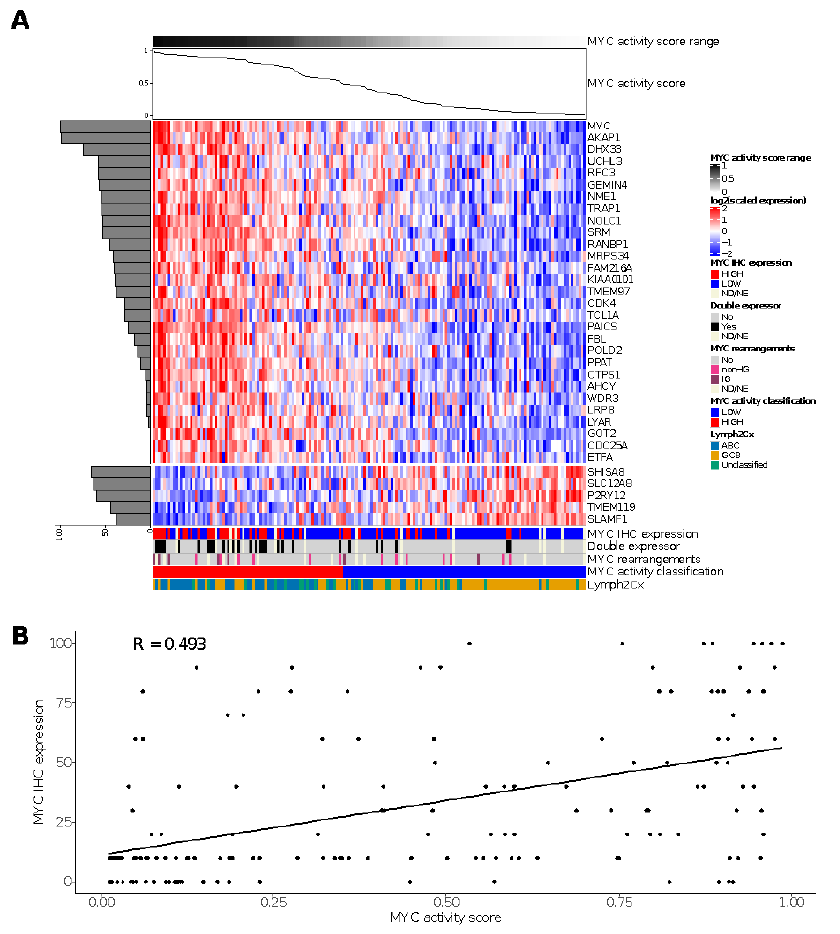
Figure 2. Results of the MYC activity classifier in the HOVON-84 cohort: ( A ) Heatmap for relative expression of the profiling panel including the relative contribution of each gene to the classifier (horizontal, shaded bar graph on the left) and the MYC activity score for the HOVON-84 cohort (line graph on top of the figure). ( B ) Spearman’s correlation between MYC activity score and MYC IHC expression for the 161 samples of the HOVON-84 cohort. ND, Not Done; NE, Not Evaluable.